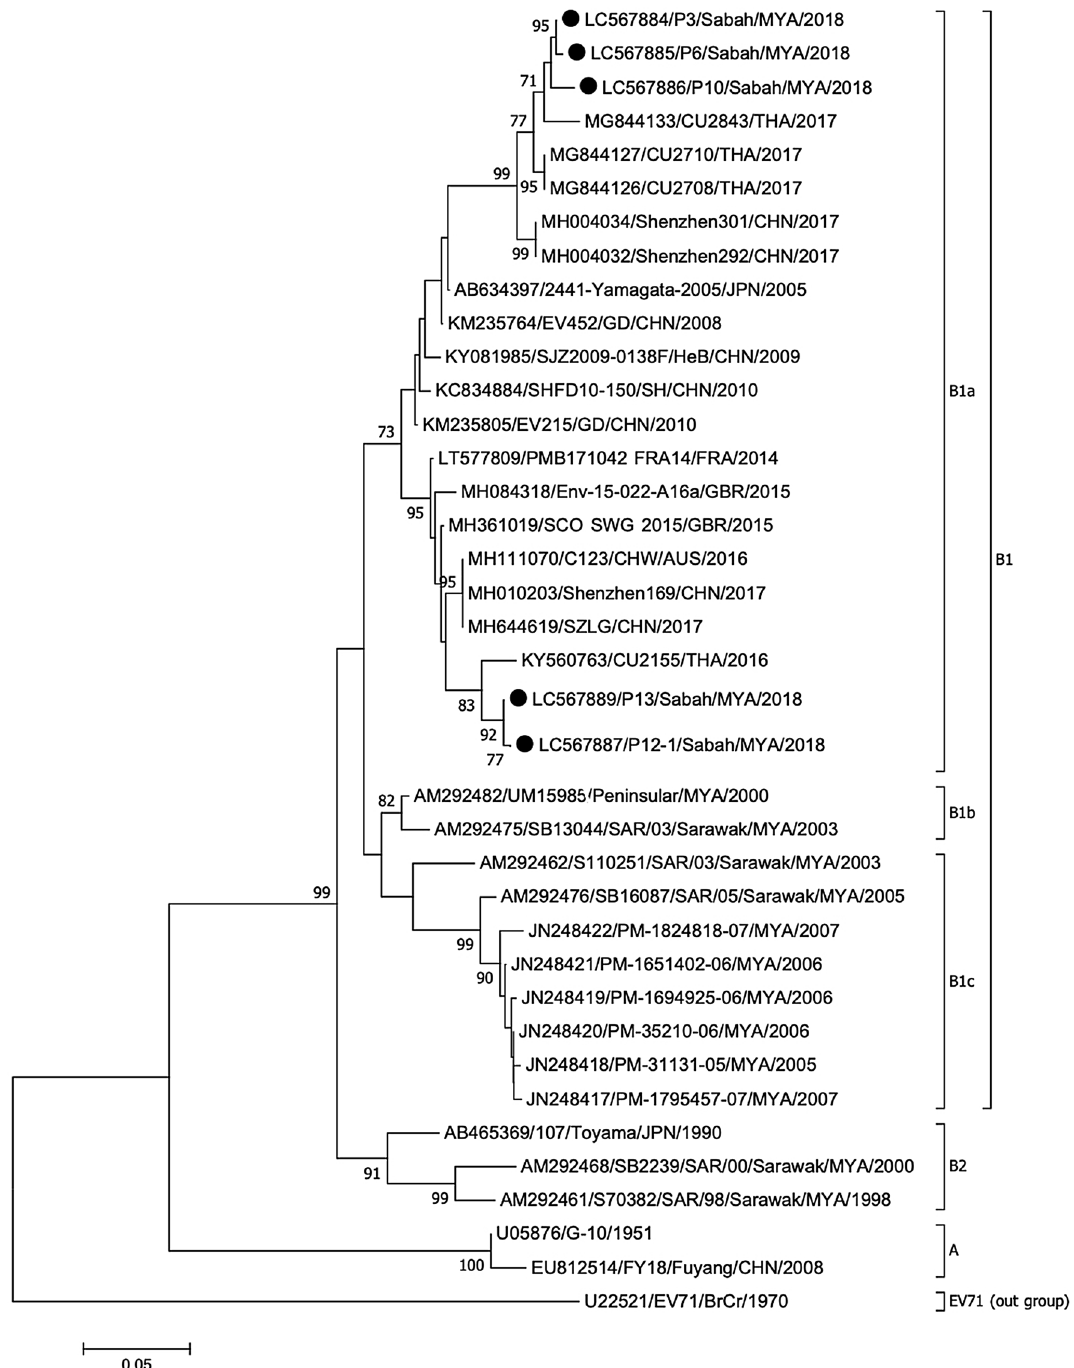
Figure 3. Phylogenetic tree constructed using partial VP1 sequences (254 bp) of coxsackievirus A16 strains by neighbor-joining method. The strains analyzed in this study are marked with a filled circle. The number adjacent to the node represents the bootstrap value; values < 70% are not shown. The scale bar at the bottom indicates the genetic distance expressed as nucleotide substitutions per site. The nucleotide sequences of our strains have been submitted to the DNA Data Bank of Japan (DDBJ) with accession nos. LC567884–LC567887 and